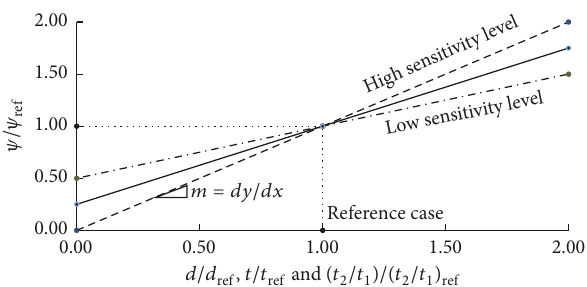
Figure 22: Concept of the sensitivity analysis.